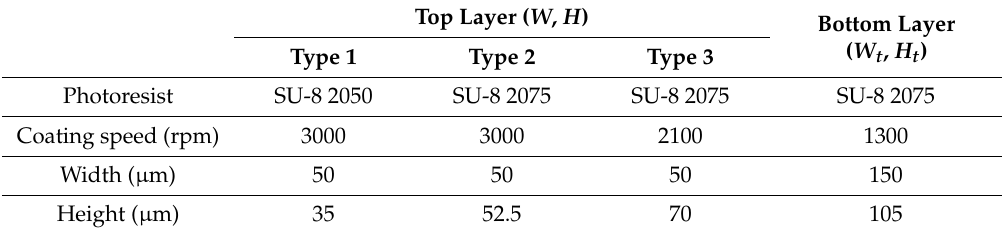
Figure 1. ( a ) Schematic 3D view of fabrication process; ( b ) design parameters between two PDMS molds (top and bottom) in microchannels with T-shaped cross-sections. Table 1. Experimental conditions for SU-8 patterning and microchannel